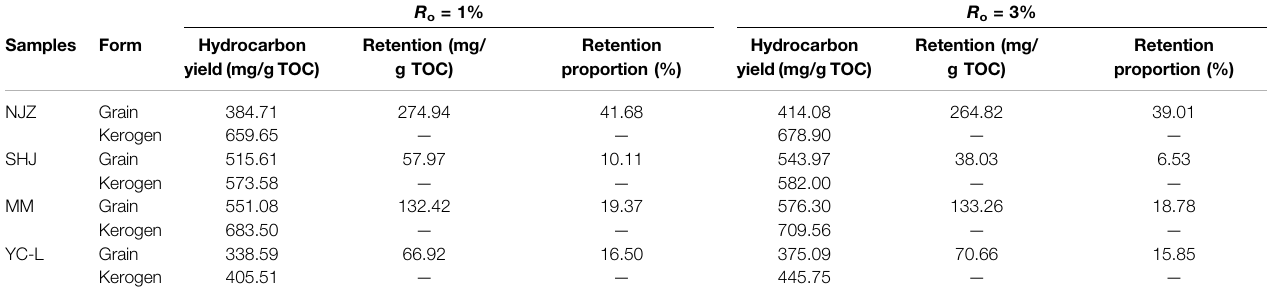
The data of YC-L were obtained from Liao et al. (2018).